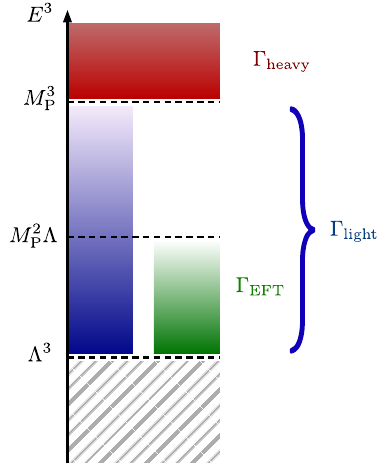
Figure 2 . The flux lattices as determined by the energy